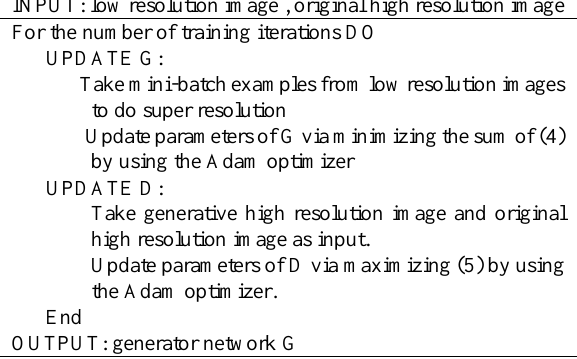
Table 1. Training procedure for our satellite image super